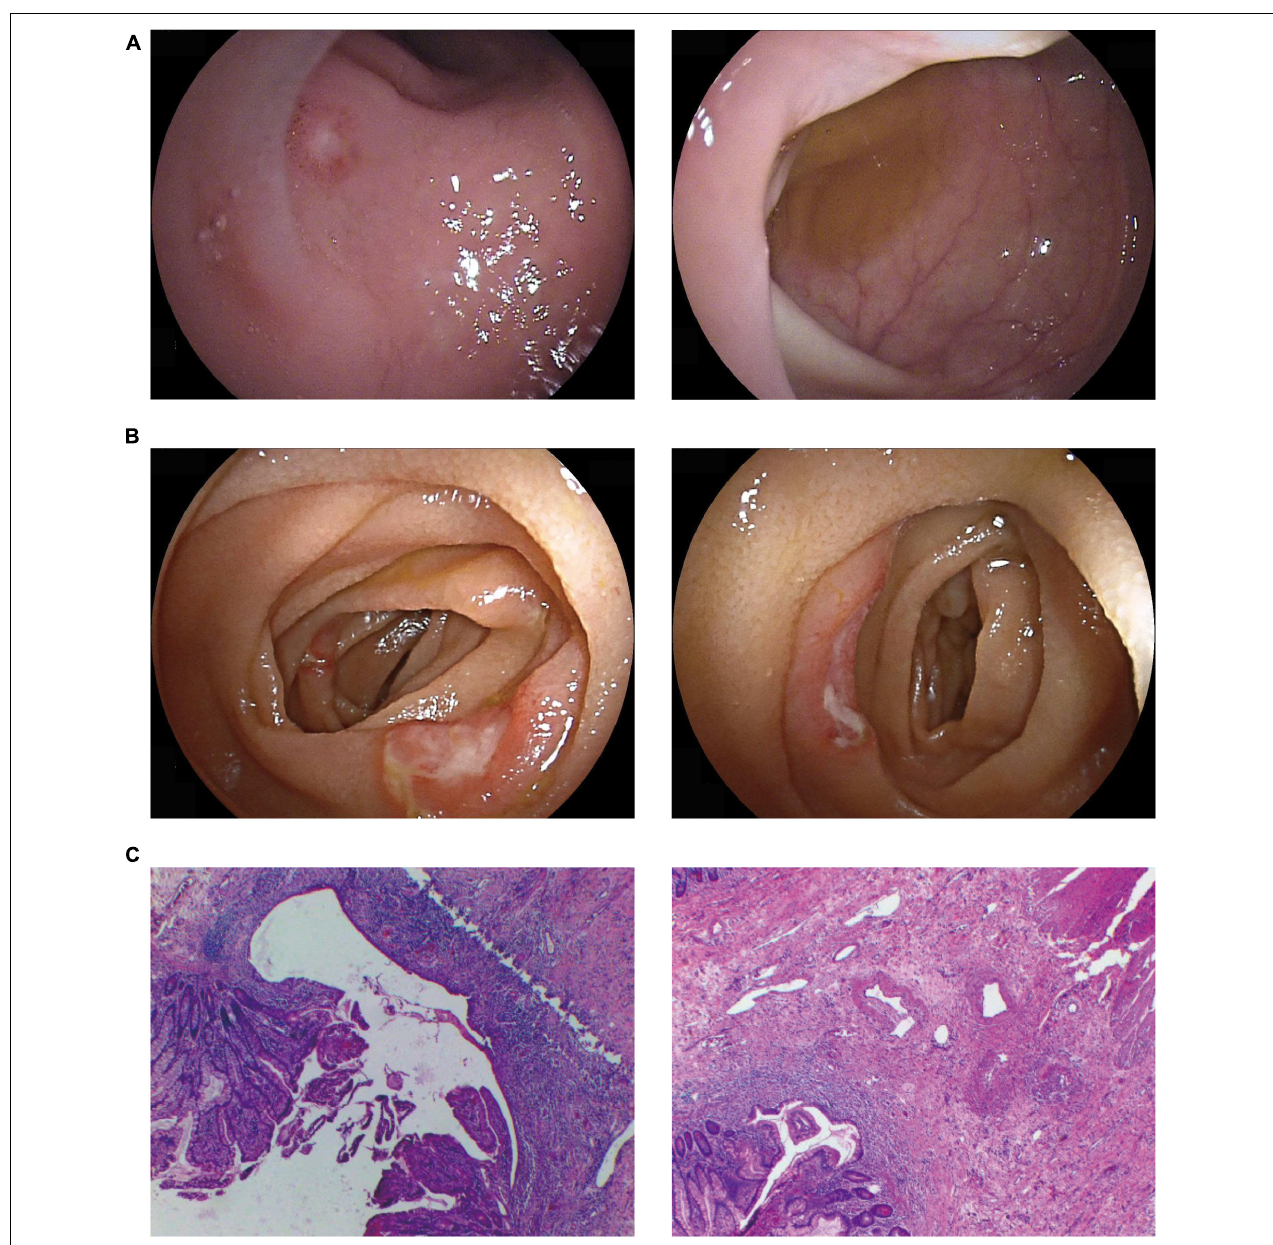
FIGURE 2 | Representative gastrointestinal involvement in our cases. Typical endoscopic findings showed multiple ulcers of terminal ileum (A) and the lower jejunum (B) . Pathology suggested multiple shallow ulcers in the small intestinal mucosa (C)